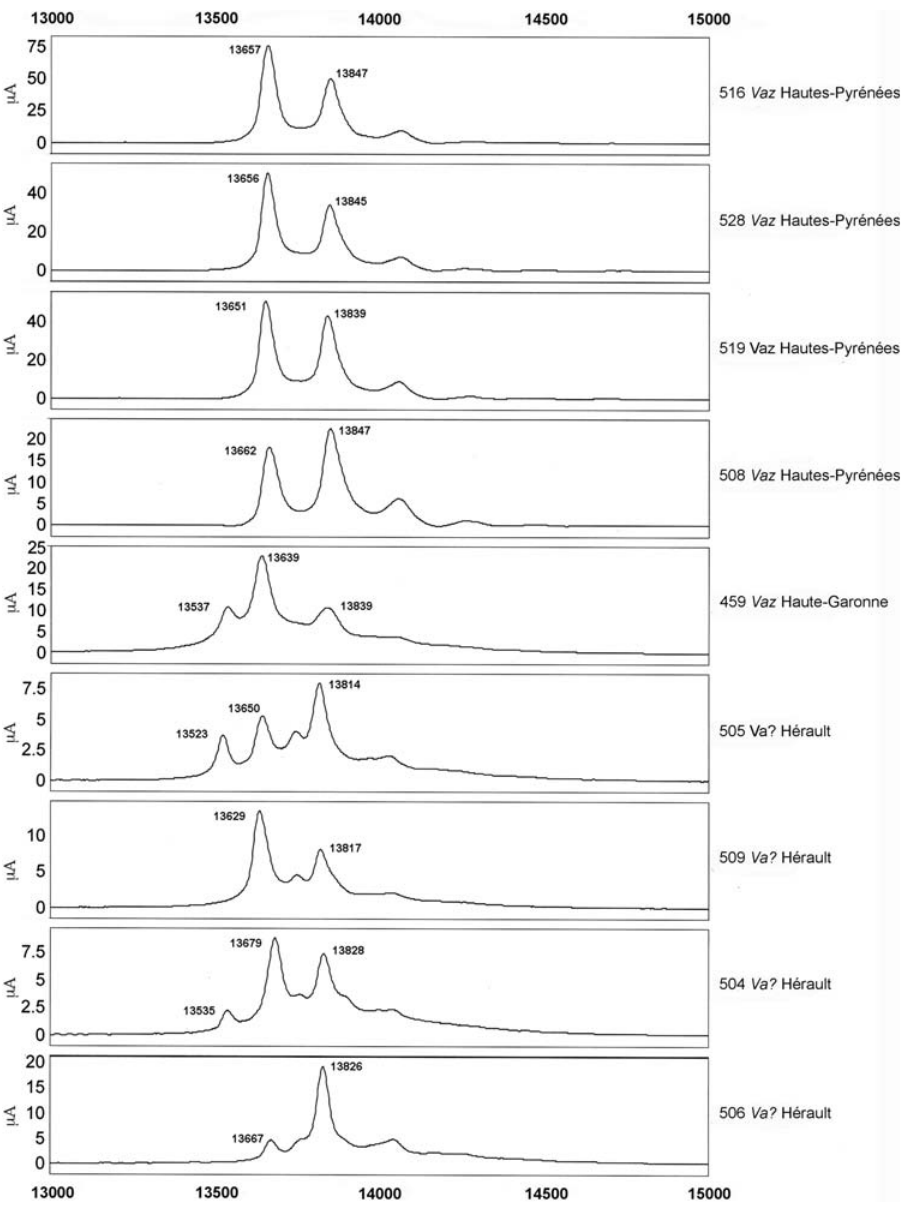
Figure 9. SELDI profiles of venoms from the south-west of France. Peak molecular weights consistent with those of PLA 2 s are indicated on the